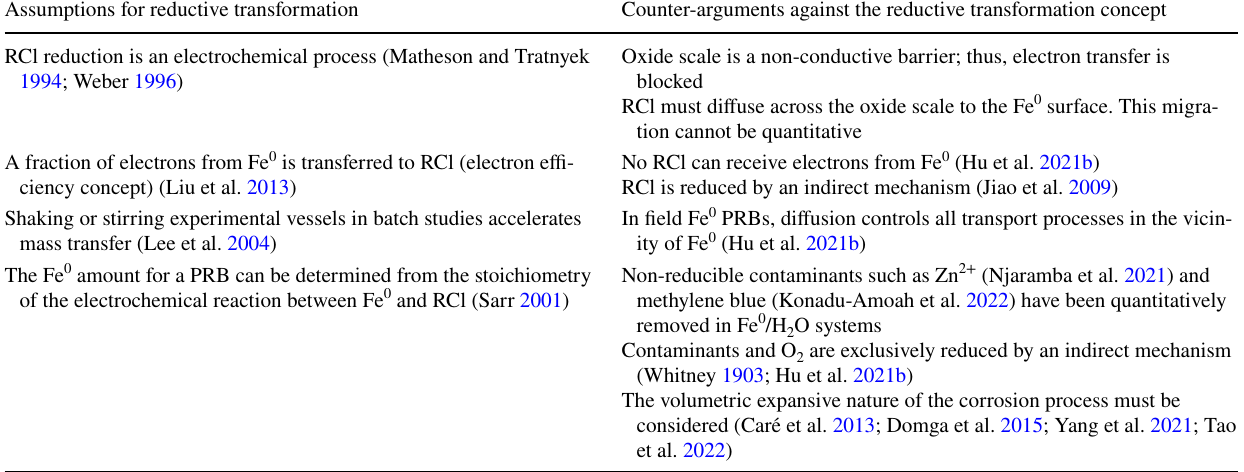
Table 3 Assumptions and counter-arguments for the reductive transformation of contaminants in Fe 0 /H